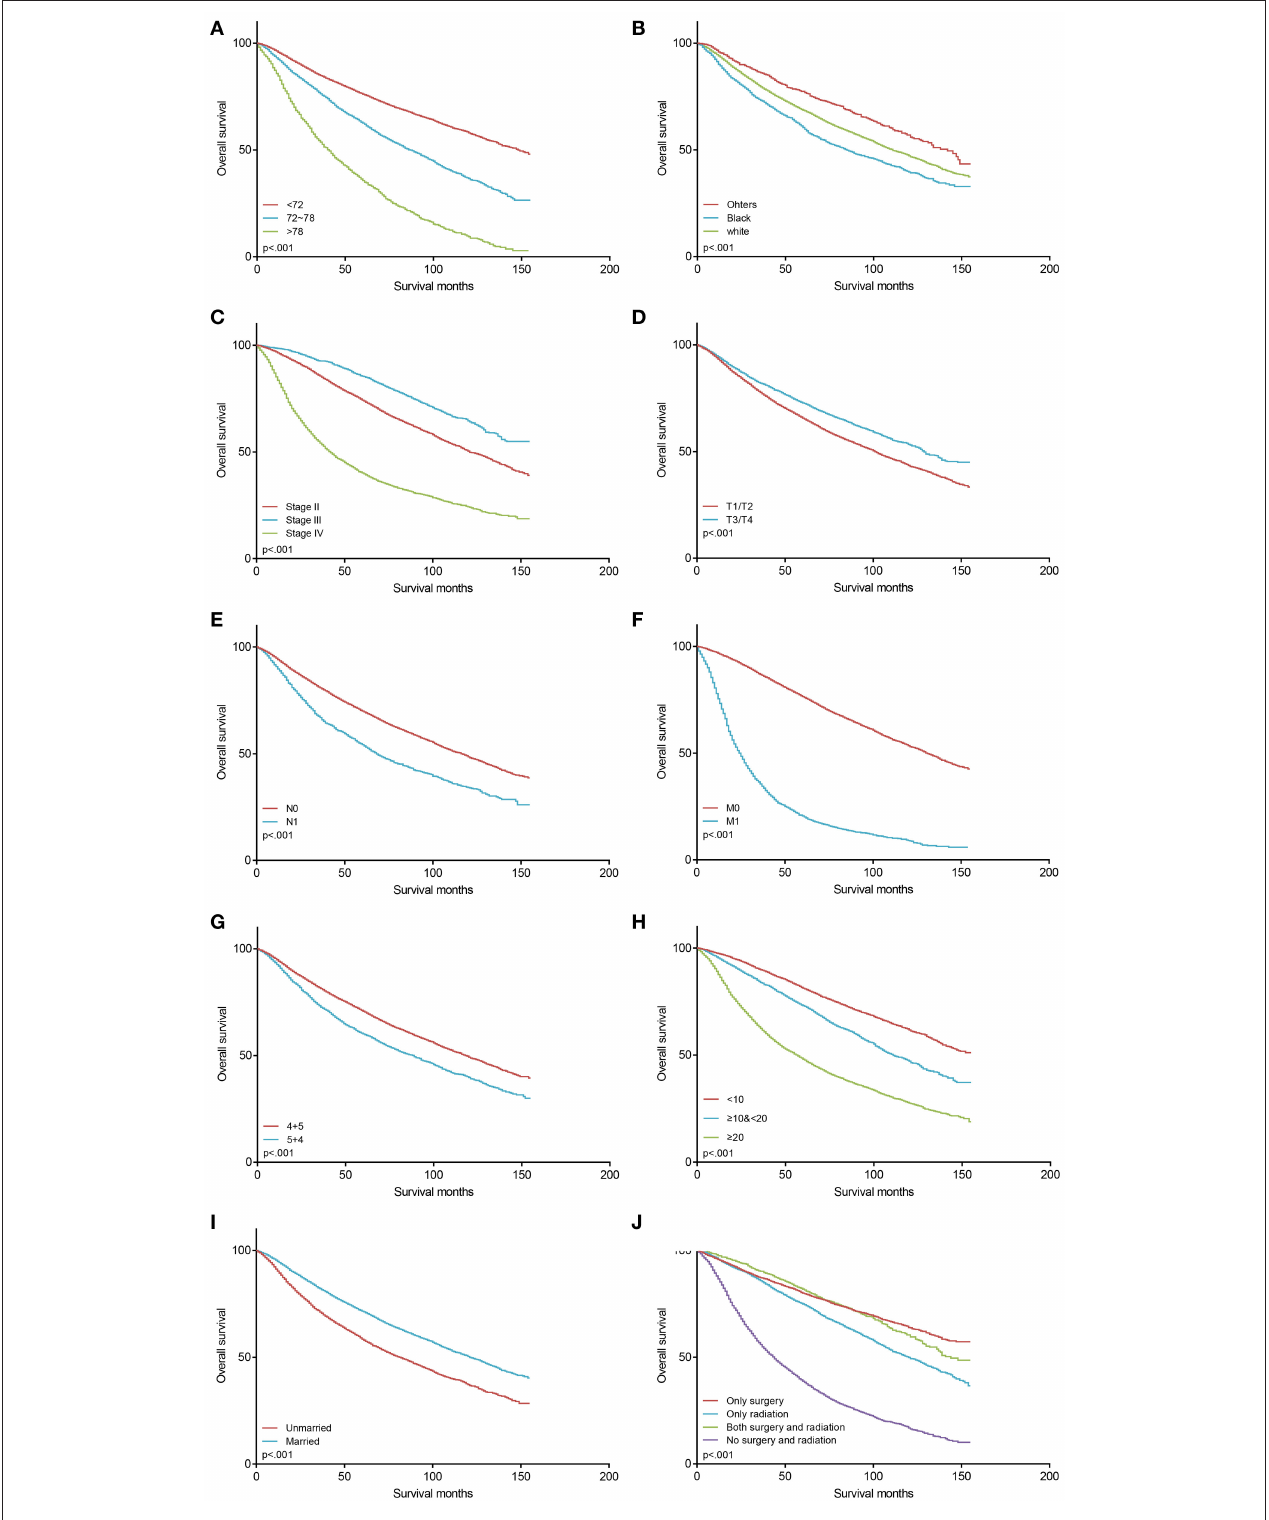
FIGURE 3 | The Kaplan–Meier survival curves of OS before PSM ( n = 10,124). (A) survival curves for age at diagnosis; (B) survival curves for race; (C) survival curves for AJCC stage; (D) survival curves for AJCC T stage; (E) survival curves for AJCC N stage; (F) survival curves for AJCC M stage; (G) survival curves for Gleason patterns; (H) survival curves for PSA levels; (I) survival curves for marital status; (J) survival curves for treatments. OS, overall survival; PSM, propensity score-matching; PSA, prostate-specific antigen.